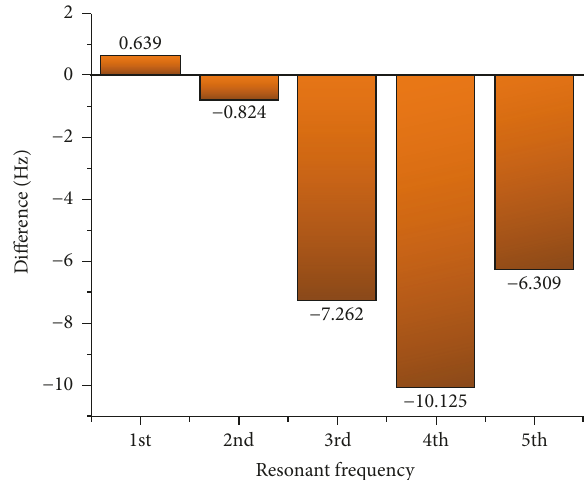
Figure 11: Differences between measured and calculated resonant frequencies.